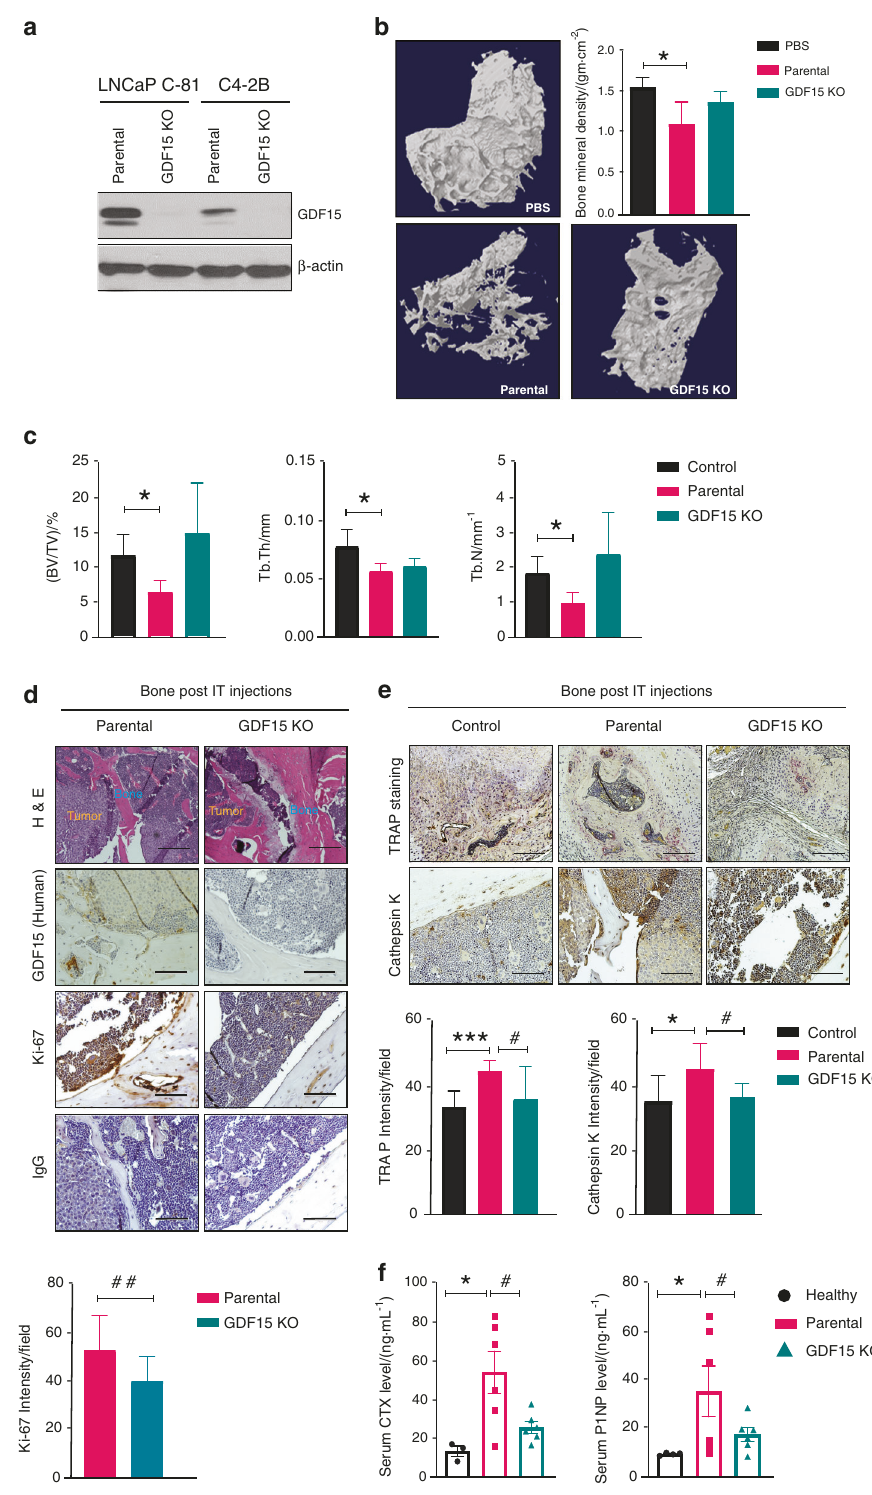
Fig. 2 PCa-GDF15 modulates the bone microenvironment and favors tumor growth in bone. a Immunoblotting of GDF15 and GDF15 KO clones of the indicated PCa cell lines. b Representative 3D reconstruction of µCT images and bone mineral density BMD/(gm·cm − 2 ) of the trabecular region of the tibia at 12 weeks after PBS (control), C4-2B (parental cell) or C4-2B (GDF15 KO) injection in mice. c µCT analysis of trabecular bone in the tibia showing the bone volume fraction (BV/TV)/%, trabecular thickness (Tb.Th/mm), and trabecular number (Tb.N/ mm − 1 ). All values are expressed as the mean ± SEM. d H&E staining of the excised tibia after decalci fi cation and immunohistochemical staining of tibiae for GDF15 (human), Ki67 and IgG. e TRAP and immunohistochemical (cathepsin K) staining of tibiae. Scale bar = 200 µm. f Serum assessment of CTX and P1NP. The data are given as the mean ± SEM ( n = at least 3 mice/group), and P ≤ 0.05 was considered to indicate statistical signi fi cance. * P < 0.05, *** P < 0.001 compared with the control group and # P < 0.05, ## P < 0.01 compared with the parental (C4-2B)-injected